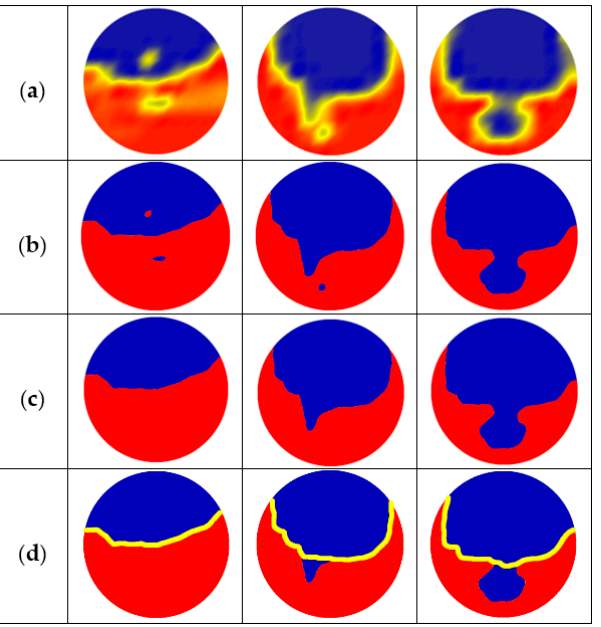
Figure 15. Flow chart for the extraction of the oil–water interface.